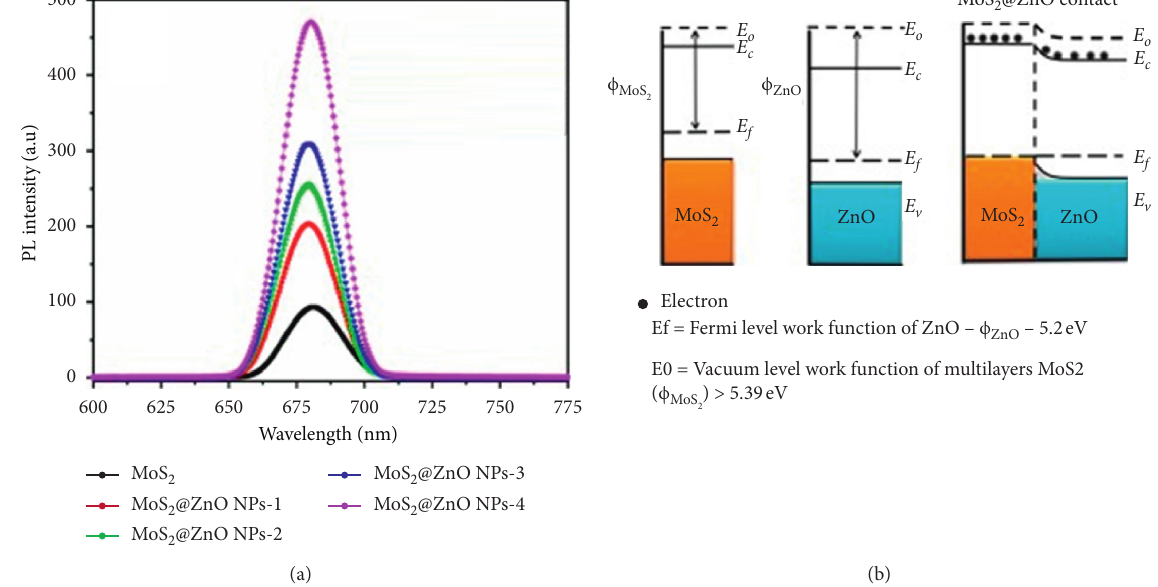
Figure 4: (a) PL spectra of MoS 2 and MoS 2 @ZnO showing the enhancement of intensity when ZnO is incorporated in the MoS 2 surface, and (b) schematic illustration of change in the charge generation and transfer process during composite formation [68].